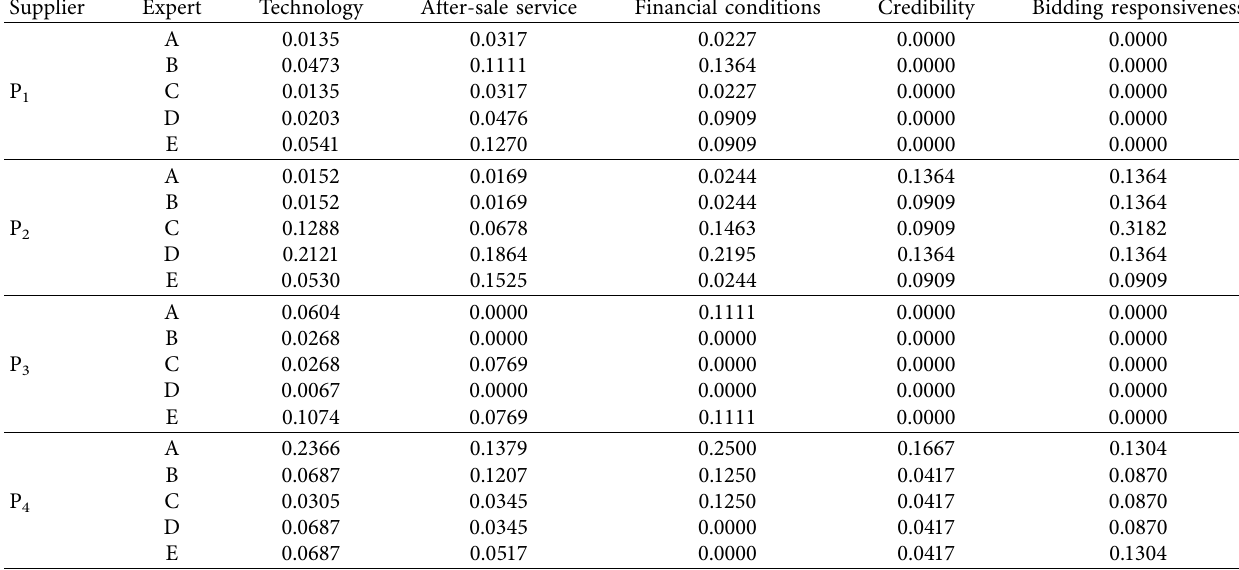
Table 2: Normalization of a group of evaluation data.